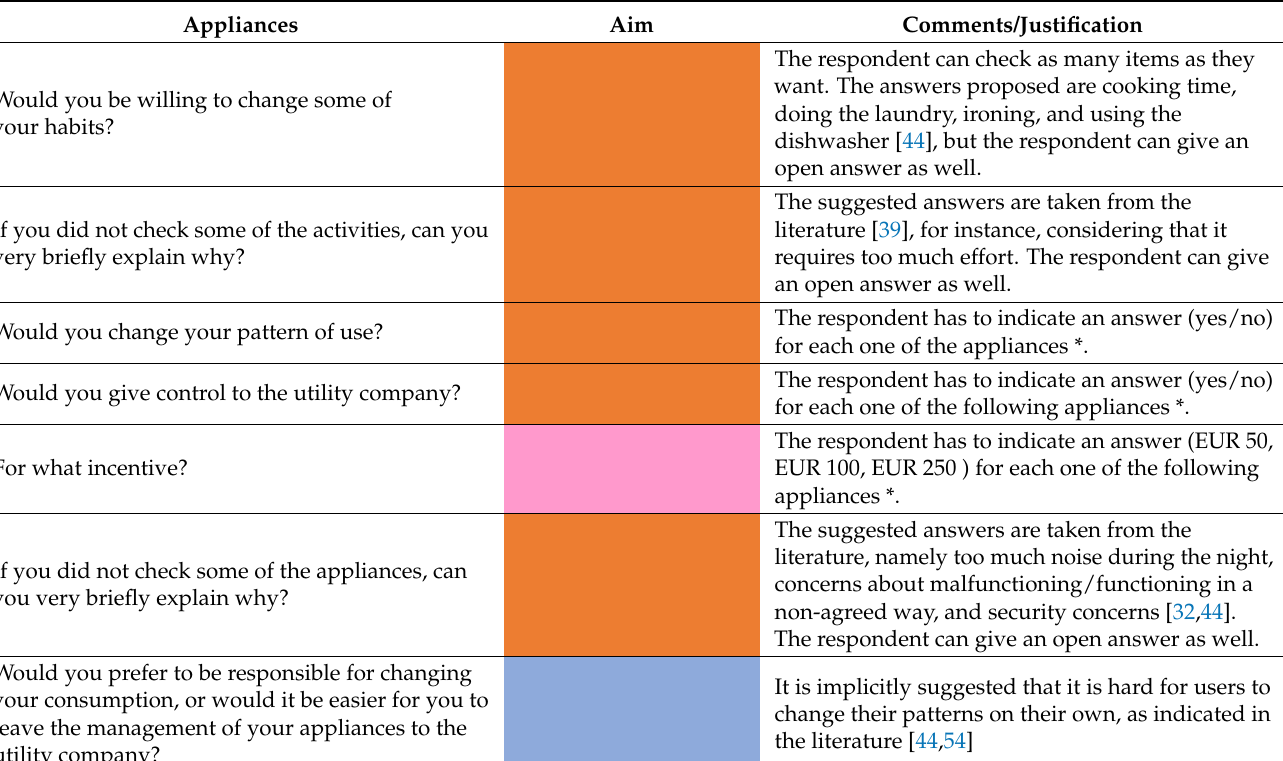
Table 4. Questionnaire—appliances section. For the colour legend and the corresponding